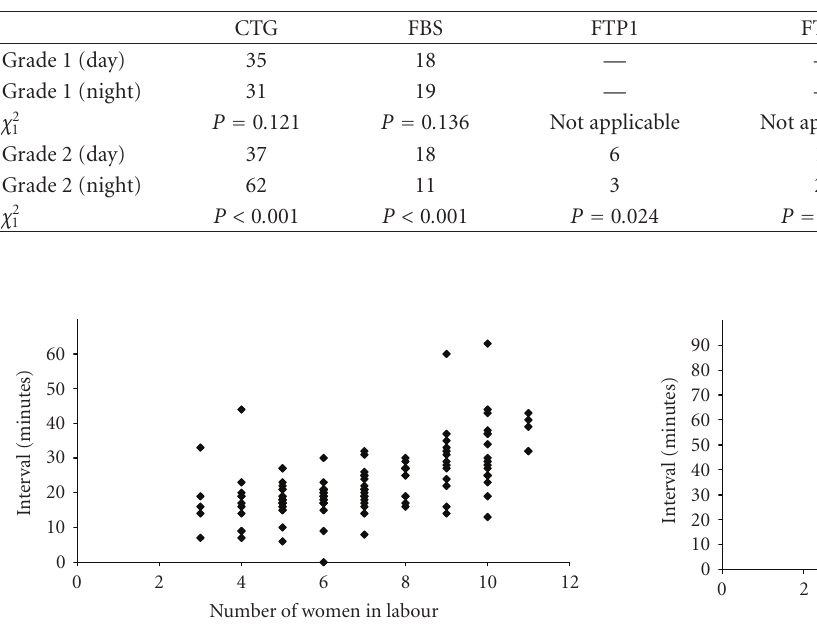
Table 1: Absolute numbers of women having grade 1 and grade 2 caesarean sections over a 12-month period. Indications are abbreviated as CTG (cardiotocographic abnormality with no fetal blood sample performed), FBS (low pH on fetal blood sampling), FTP1 (failure to progress in the first stage of labour), FTP2 (failure to progress in the second stage of labour), and Failed IVD (failed instrumental vaginal delivery, including forceps, ventouse or both). Denominator data for analyses included 2620 women giving birth in daytime hours (excluding elective caesarean sections) and 2547 women giving birth overnight.